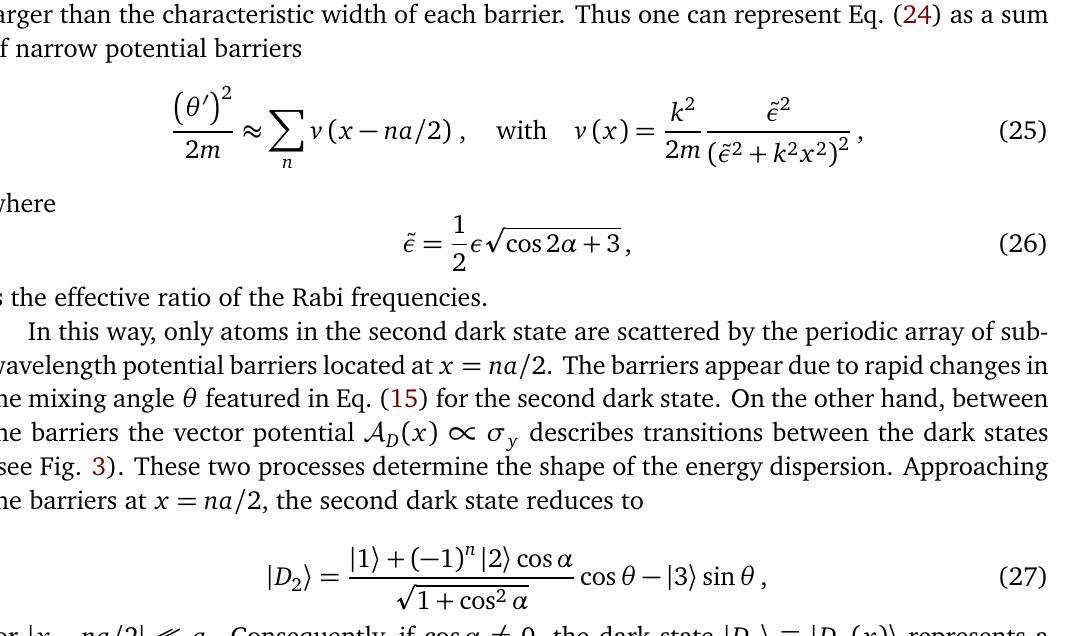
Figure 3: The modulus of the Rabi frequencies Ω = φ (cid:48) sin θ and c = − θ (cid:48) defining the geometric scalar potential V c 1 2 (second row), as well as the quantity φ (cid:48) cos θ entering the geometric vector potential ( x ) in Eq. (19) (third row) for ε = Ω A D